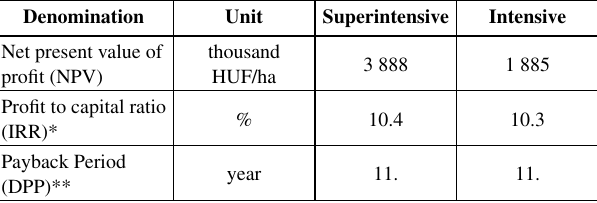
Figure 1: The Tendency of NPV during the Lifetime of the Orchard Source: own Table 4: Investment Indicators Relating to the Examined Orchards